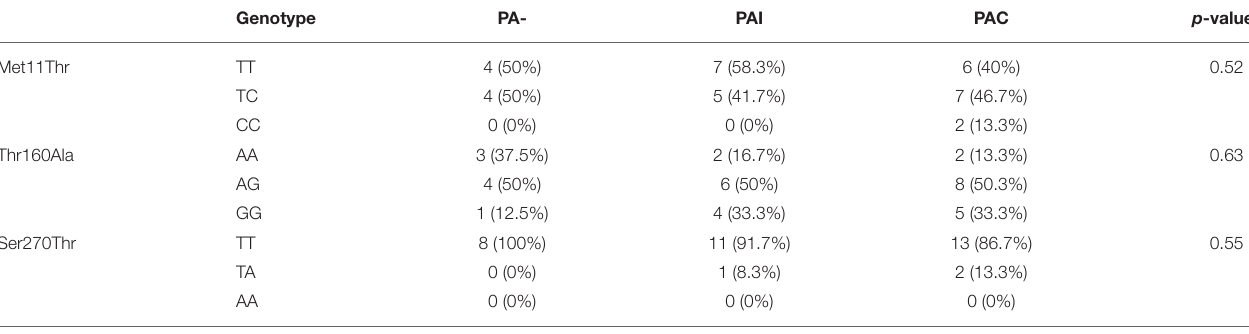
TABLE 4 | Distribution of genotypes of the SNPs in the SFTPD coding gene in CF patients. Genotype PA- PAI Met11Thr